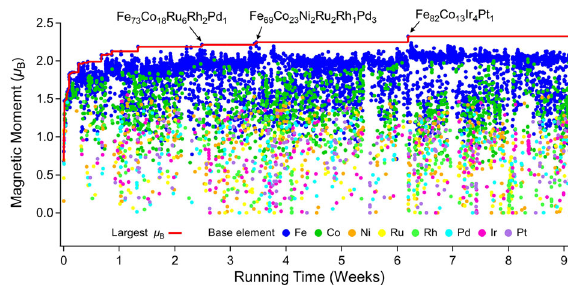
Fig. 2 Growth of autonomous materials search system. Growth of the autonomous materials search system for an alloy with a large magnetic moment. Magnetic moment data were plotted for each search cycle shown in Fig. 1b. Colors of data points show the base element of the alloys. After some time, the autonomous system was able to fi nd a better composition for a disordered multi-element alloy (Fe a Co b Ni c Ru d Rh e Pd f Ir g Pt h ) with a large magnetic moment due to an increase in the amount of data for learning. After 6 weeks (strictly, 43 days) of growth, the autonomous system arrived at Fe 82 Co 13 Ir 4 Pt 1 , not the composition of the alloy at the top of the Slater – Pauling curve (Fe 75 Co